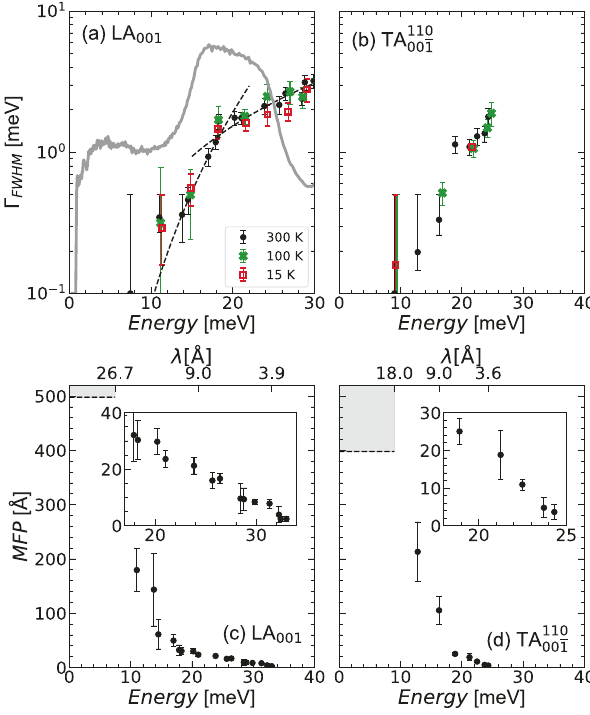
Fig. 8 | Intrinsic phonon linewidths, measured by inelastic X-ray scattering. Subplots ( a , b ) show linewidths measured at three temperatures. For the sake of clarity,in(a)wereportonlythe fi rsttwobroadeningregimes,upto30meV,forthe longitudinal mode, together with ( ℏ ω ) 4.5 and ( ℏ ω ) 1.7 lines (black dashed lines) as a guide to the eye. The FeCoCrMnNi generalized vibrational density of states (GVDOS) originally shown in Fig. 2(b), divided by energy squared and scaled, is plotted in gray in ( a ) for reference. Subplots ( c , d ) are mean free paths (MFPs), calculated from the intrinsic linewidths at 300 K. Error bars correspond to the standard deviation as calculated using the error propagation theory.Below~10 meVthephononlinewidthcouldnotberesolvedwithourexperimentalresolution. Thisallowsusonlytoestimateanupperlimitforintrinsiclinewidth,i.e.alowerlimit forlifetimeandMFP.Theshadedareasinthe fi gureindicatetheregioninwhich,on this basis, the real MFP